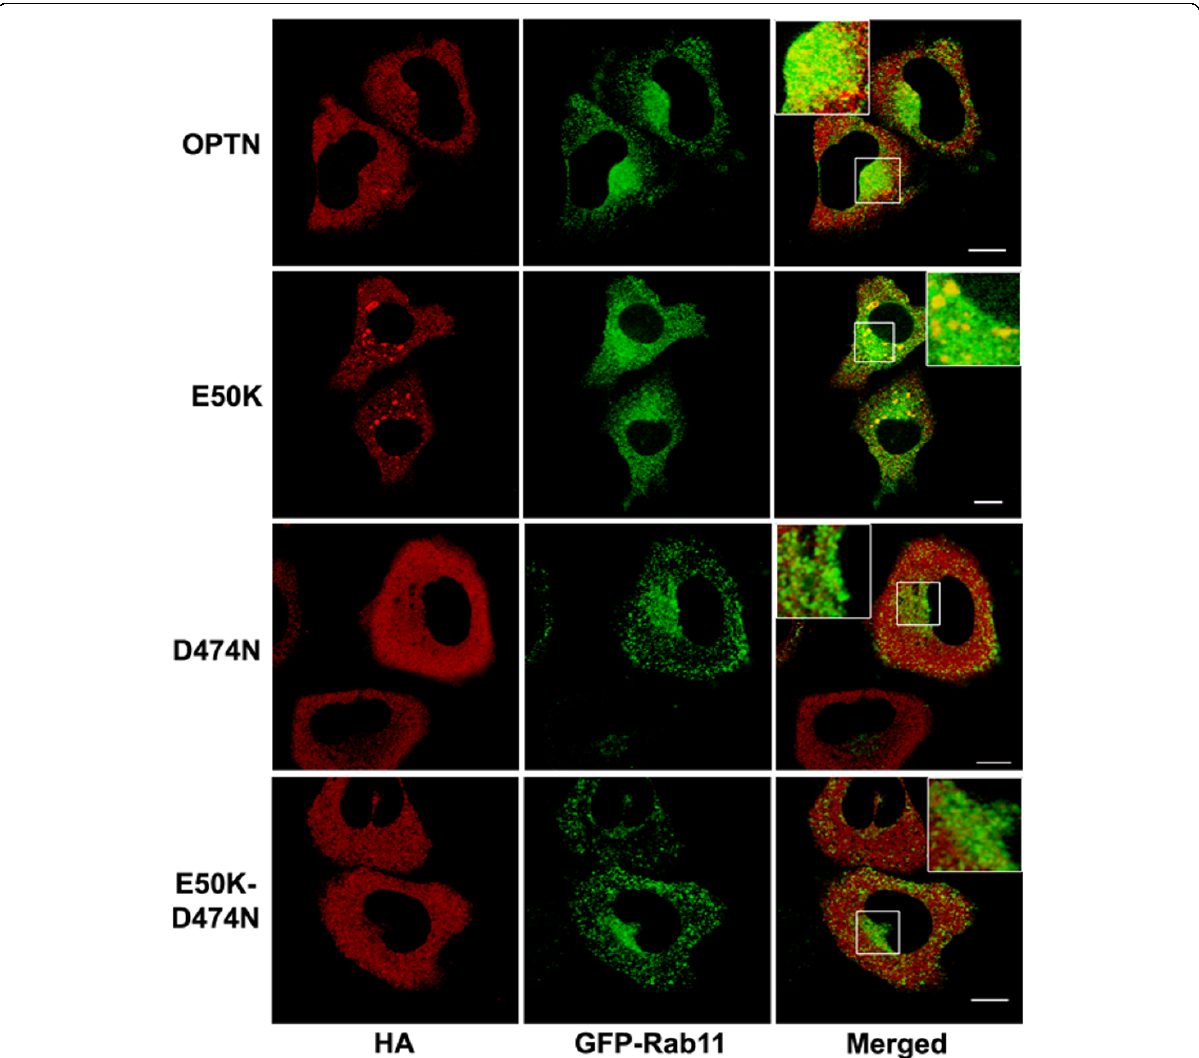
Figure 5 Colocalization of optineurin and E50K mutant with Rab11 . HeLa cells were co-transfected with HA-tagged wildtype optineurin or its mutants and GFP-Rab11. Both wildtype optineurin and E50K mutant show colocalization with Rab11. Insets show enlarged region of the boxed area. Correlation coefficients for co-localization, wild-type optineurin, 0.32 ± 0.04; E50K, 0.45 ± 0.08; D474N, 0.07 ± 0.03; E50K-D474N, 0.08 ±